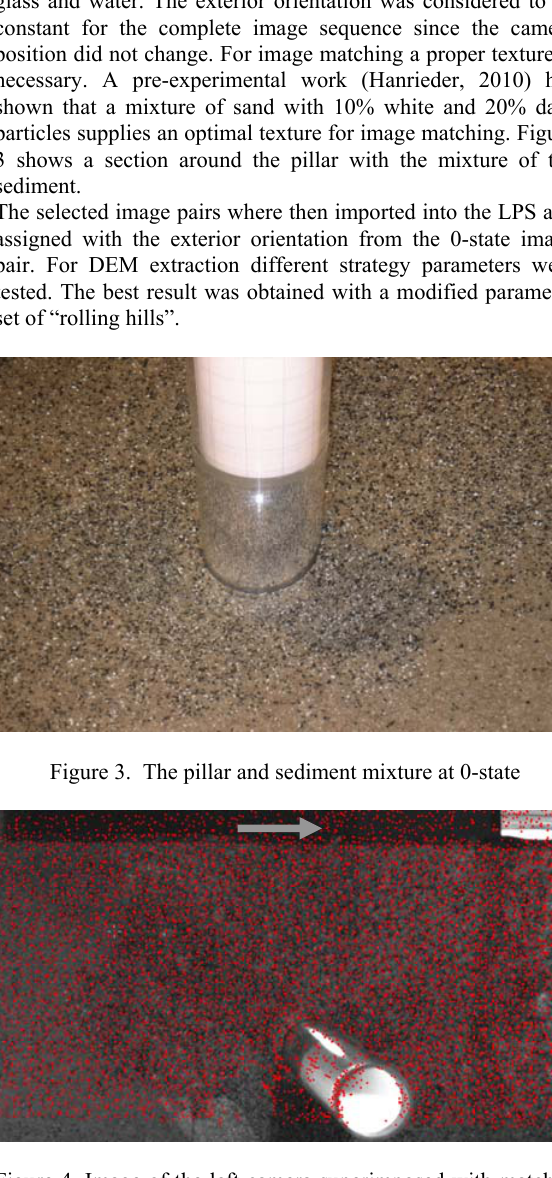
Figure 4. Image of the left camera superimposed with matched points The image pairs were than processed in batch mode returning about 8000 well distributed object points (Figure